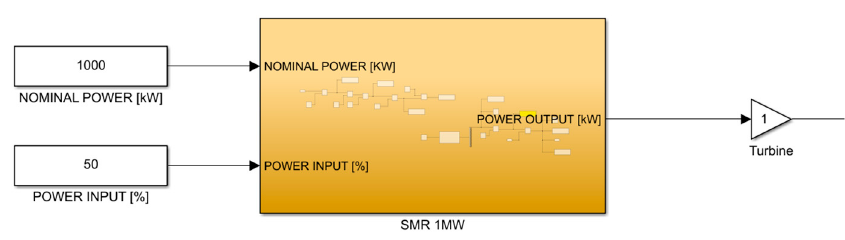
Figure 16. Simulink block: SMR.